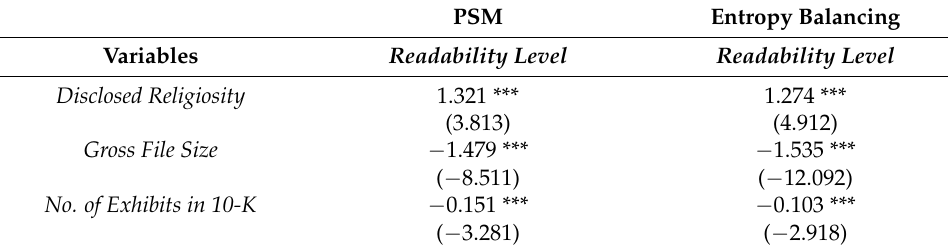
Table 8. CEO Religiosity and Readability—PSM & Entropy